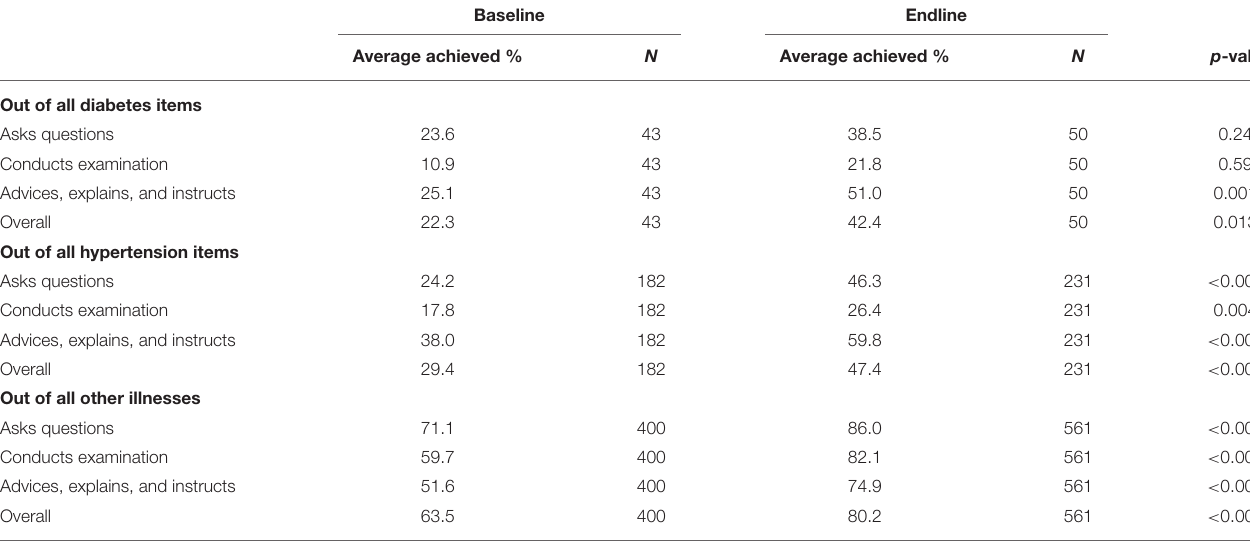
TABLE 3 | Clinical observation score—average achieved % out of all items for diabetes, hypertension and “other illnesses.” Baseline Endline Average achieved % N Average achieved % N p -val